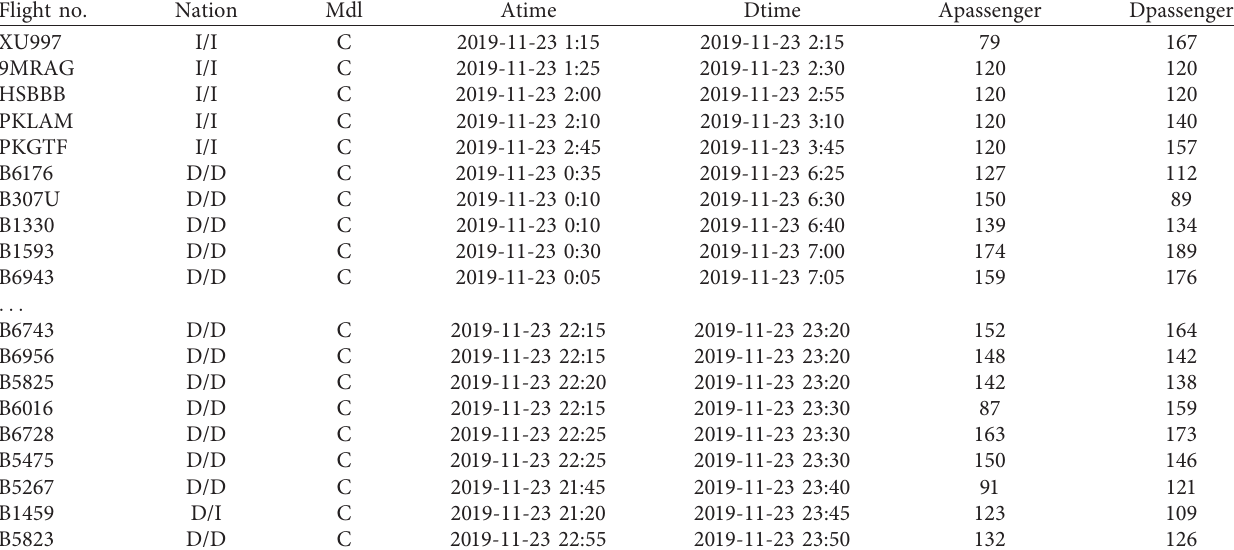
Table 6: Flight pair data samples of Kunming Changshui International Airport on November 23, 2019. Flight no.